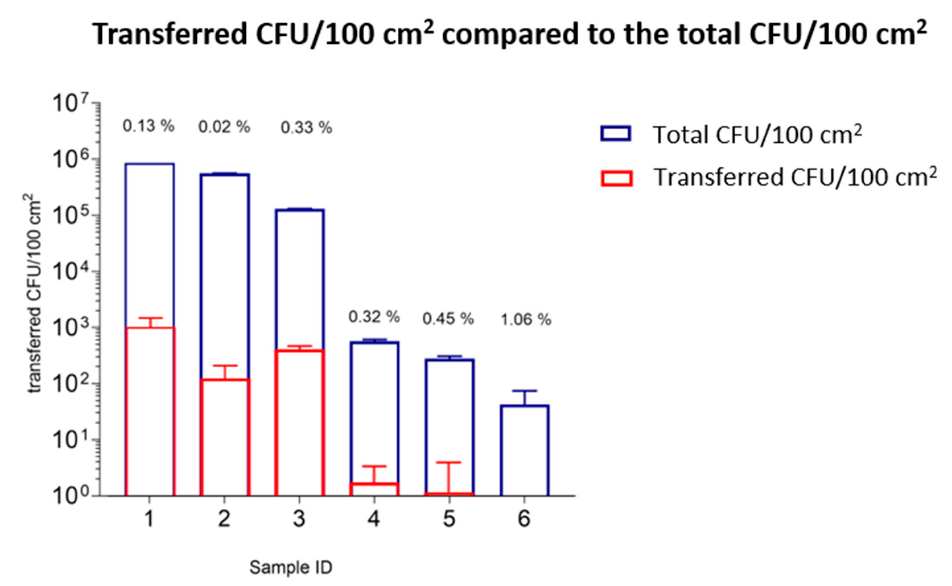
Figure 7. The number of transferred microorganisms to a contact surface is not related to the total bacterial loading of the samples. The samples are listed with respect to the decreasing bacterial loading (CFU/100 cm 2 ). The blue bars present the total number of CFU/100 cm 2 of each sample. Red bars depict the transferred microorganism from the outer layers of the packaging material to the TSA plates, after the samples were loaded with 250 g for 30 min. For each sample, the transfer ratio (%) was calculated. Sample 1, with the highest number of CFU/100 cm 2 (8.63 × 10 5 CFU/100 cm 2 ), did not demonstrate the highest transfer ratio (0.13%) compared to the other tested samples. In contrast, the sample with the lowest bacterial loading, sample 6 (6.49 × 10 1 CFU/100 cm 2 ), showed the highest transfer ratio (1.06%). Therefore, the transfer ratio was not associated with the total bacterial loading of tested samples. Table 6. Transfer analysis considering transfer ratios and number of CFU/100 cm 2 of tested samples to tryptone soy agar (TSA) plates. The samples are labeled with respect to their numbers of colony- forming units per 100 square centimeters (CFU/100 cm 2 ) in descending order (1–6). The experi- mental set-up was performed as described in Figure 2(2). Data are shown as mean ± SD. The transfer ratios are declared as a percentage (%). A p -value of <0.05 was defined as statistically significant.